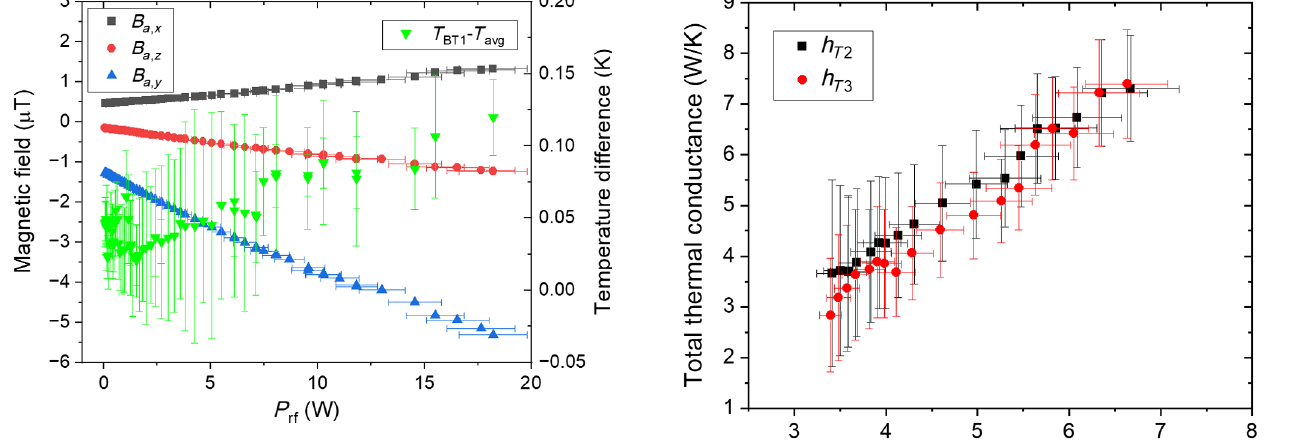
FIG. 28. B at different locations of the cavity equator ring, a along three orthogonal directions, and temperature difference − T T as a function of P , measured during the high-power BT1 avg rf rf test after the first cooldown.